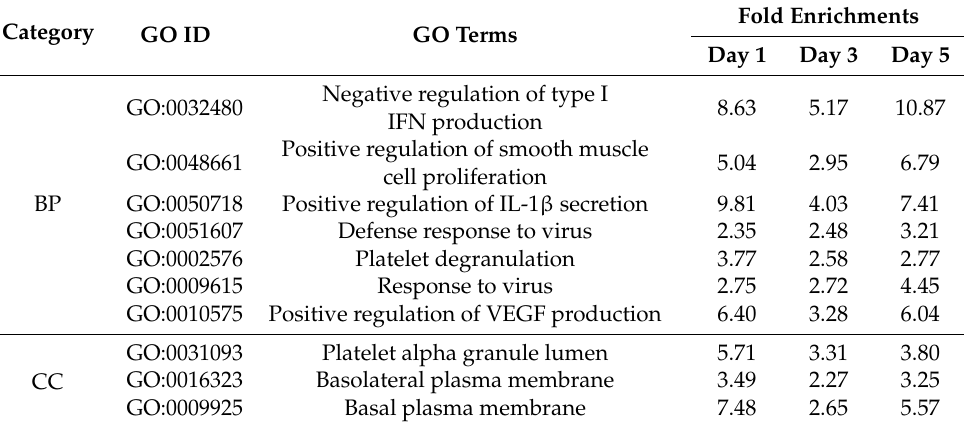
Table 2. GO terms commonly identified at all time points in IHNV-infected fish.